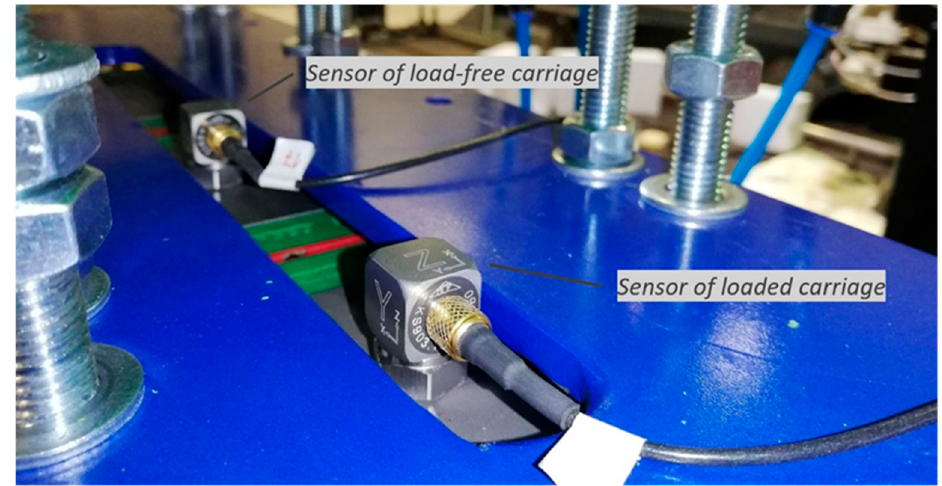
Figure 9. The placing of three-axis acceleration sensors.